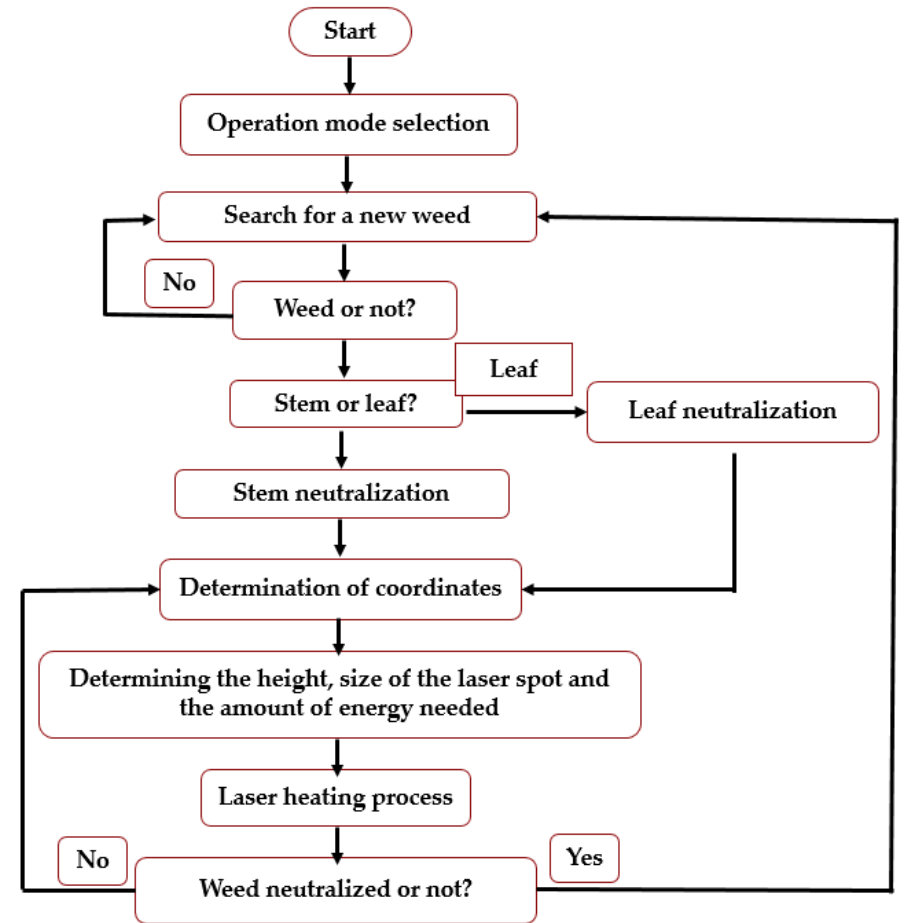
Figure 6. A decision model for the weed control device.